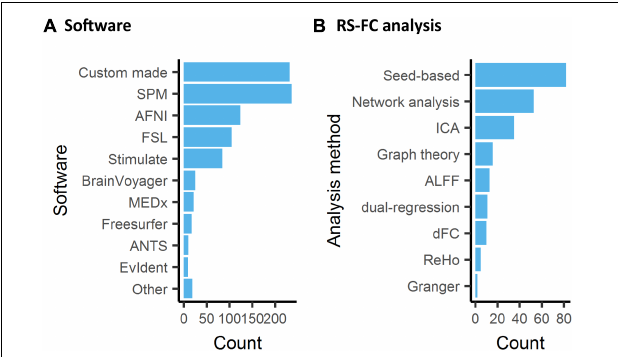
FIGURE 6 | Software used for data analysis of animal fMRI and functional connectivity analysis. (A) Custom made software or combination of existing software pipelines remained the most common approach to animal fMRI data processing, while SPM was the most used software package used. (B) Resting-state fMRI in animals is mainly analyzed with seed-based